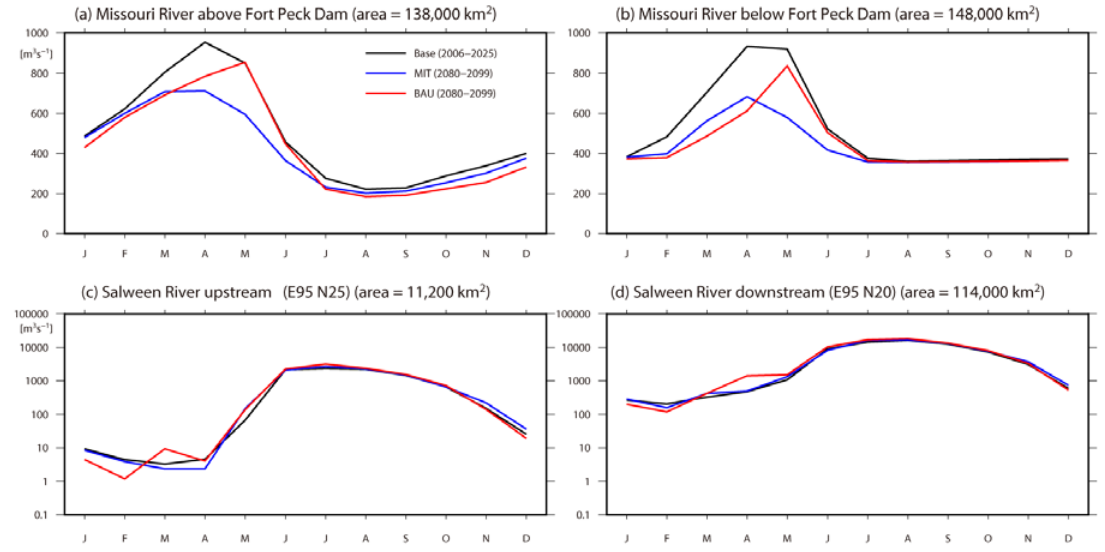
Figure 5. Mean monthly flow ( a ) above and ( b ) below the Fort Peck Dam of the Missouri River, and in ( c ) upstream (95°E 25°N) and downstream (95°E 20°N) reaches of the Salween River. Please note that a logarithmic vertical axis is used for ( c ) and ( d ). Black, blue, and red lines show the base period